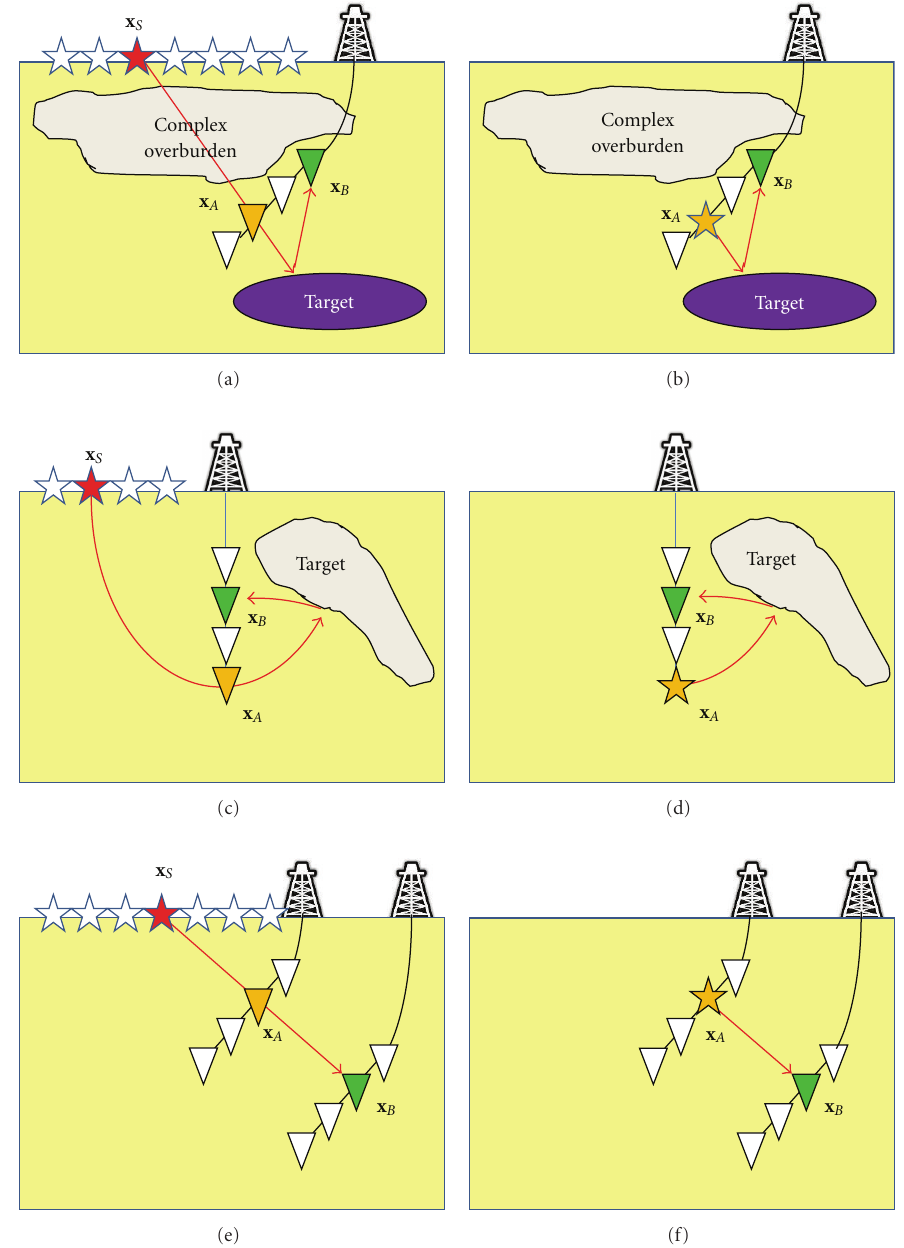
Figure 1: Typical redatuming problems: (a) input data for redatuming through complex overburden; (b) output data after redatuming through complex overburden (with some types of interferometry, the overburden is replaced by a homogeneous halfspace); (c) input data for flank imaging; (d) output data for flank imaging after redatuming; (e) input data for virtual cross-well; (f) output data after virtual cross-well; x S denote the source locations, x A denote the receiver locations that are turned into virtual sources, and x B denote other receiver